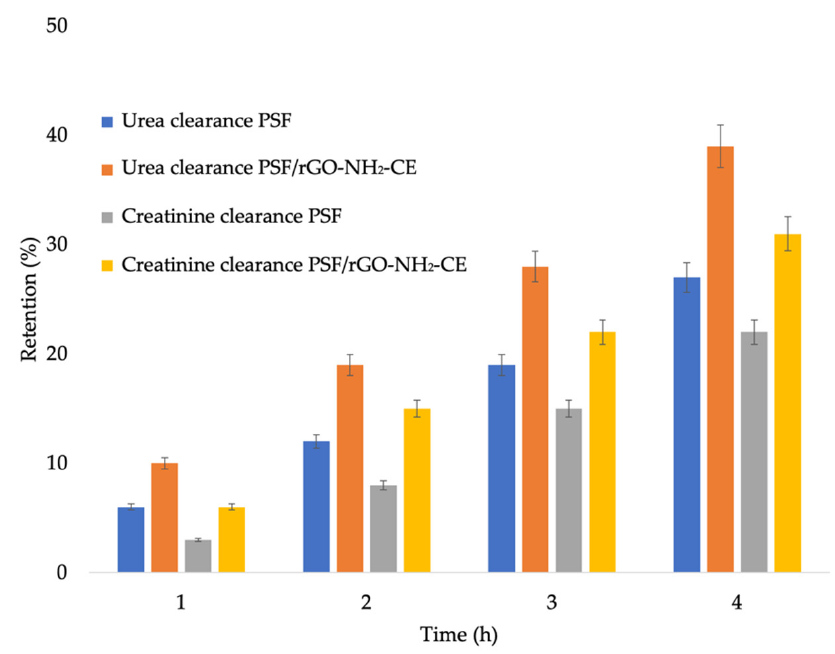
Figure 11. Urea and creatinine clearance through polysulfone and polysulfone composite membranes after 4 h of recirculation.